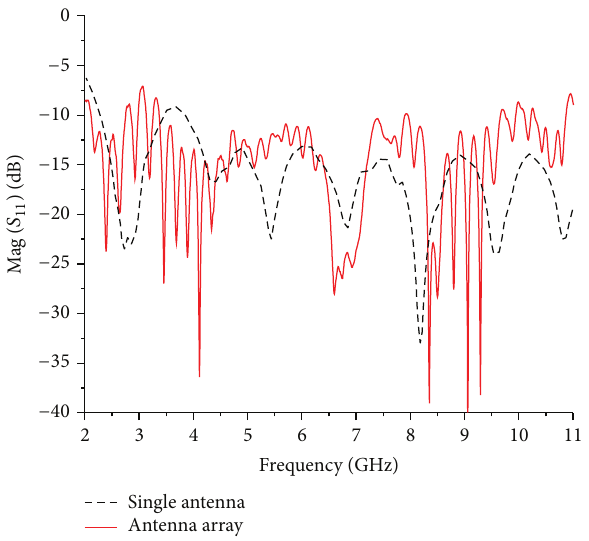
Figure 7: Measured reflection coefficient of single antenna and antenna array.